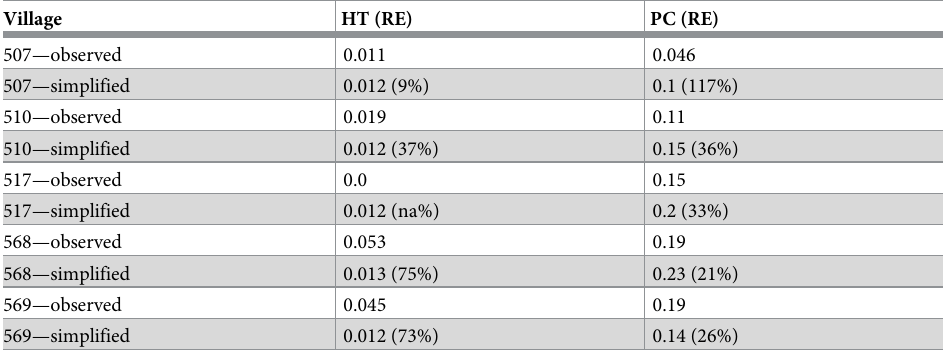
Table 9. Calibration validation